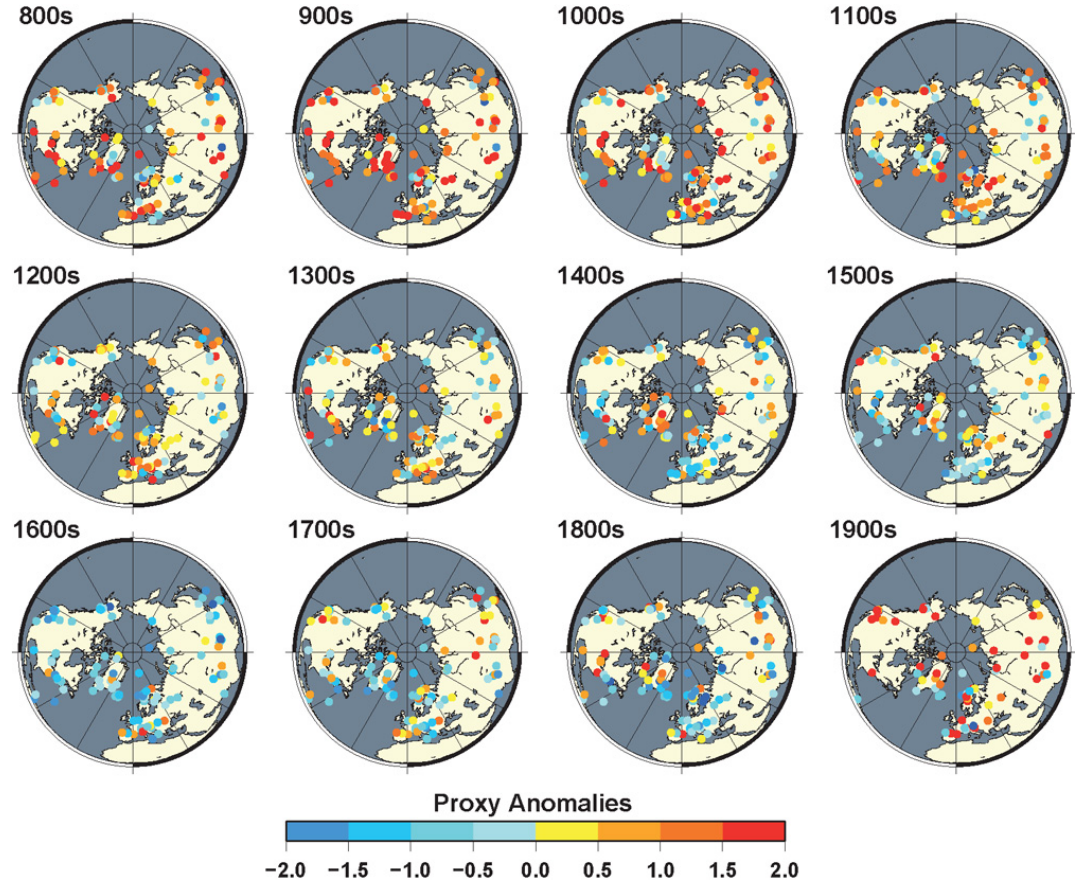
Fig. 2. Raw, centennial, proxy anomaly values. Anomalies are shown relative to the centennial mean and standard deviation over the 11th–19th centuries. The colour scale is truncated at − 2 and